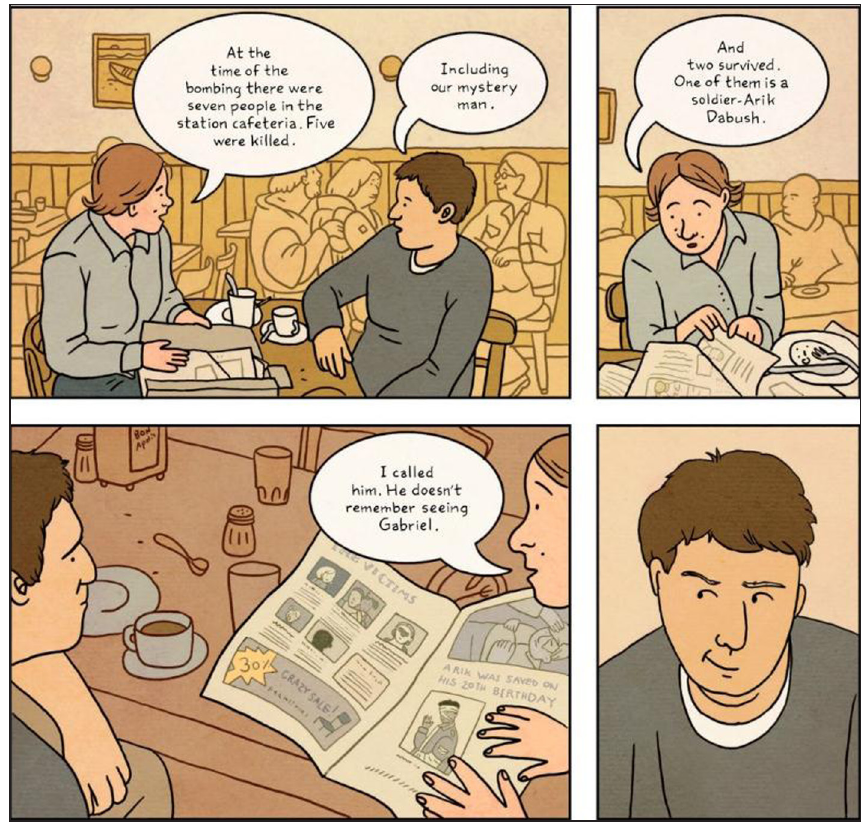
Figure 5: Everyday Death and Boredom in Exit Wounds by Rutu Modan, 2007: 64. © 2007 Drawn & Quarterly – Rutu